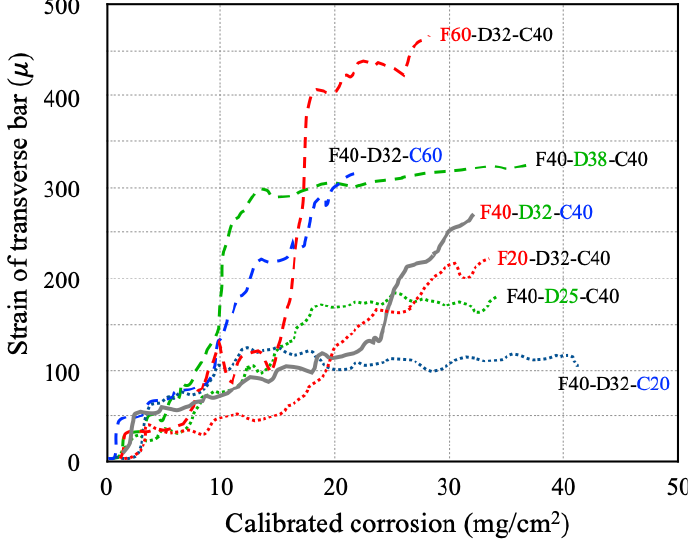
Figure 11. Relationship between the calibrated corrosion amount and transverse bar strain.